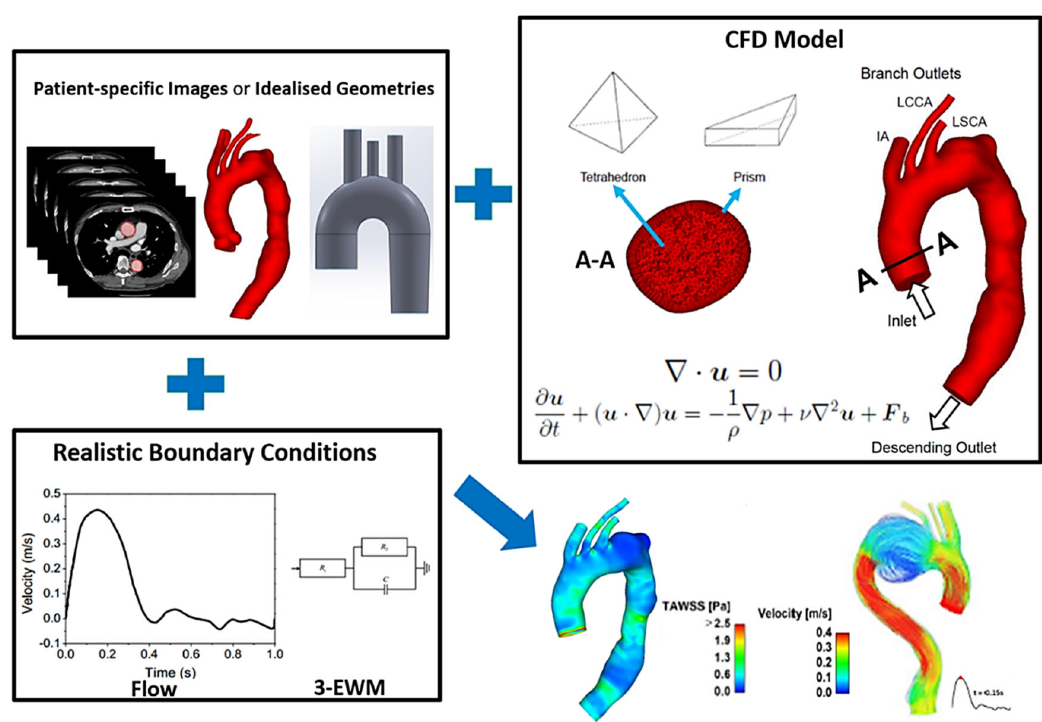
Figure 4. Schematic of the key stages involved in computational flow modelling of the aortic arch. Blood is a complex fluid and is a combination of red blood cells, white blood cells, platelets and other agents suspended in a fluid plasma. It therefore tends to exhibit non-Newtonian characteristics with a shear-dependent viscous behaviour. Blood is a shear- thinning fluid, which means that the viscosity of blood decreases as the shear rate